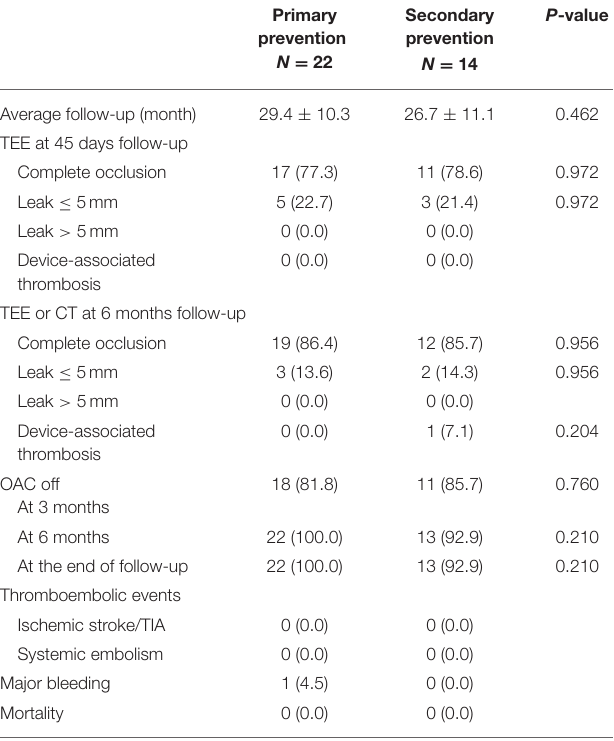
TABLE 3 | Outcomes at